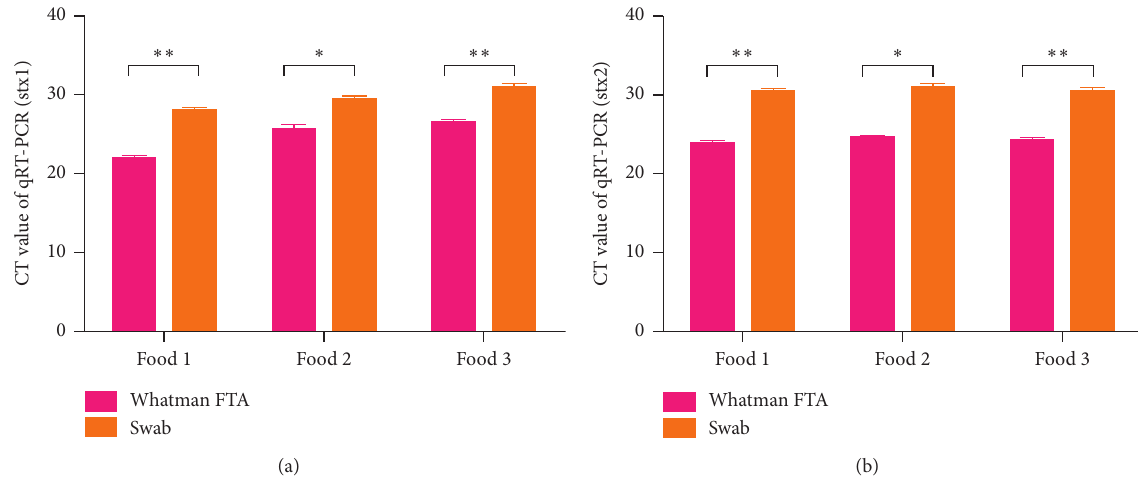
Figure 3: Detection of Escherichia coli O157:H7 genes in food samples containing Escherichia coli O157:H7 contamination by RT-qPCR collected using Whatman FTA cards and swabs. (a) Expression level of the stx1 gene in a serially diluted environmental strain of Escherichia coli O157:H7 samples on Whatman FTA cards and swabs detected by RT-qPCR ( n � 6, ∗ P < 0 . 05 and ∗∗ P < 0 . 01). (b) Expression level of the stx2 gene in an environmental strain of Escherichia coli O157:H7 samples on Whatman FTA cards and swabs detected by RT-qPCR ( n � 6, ∗∗ P < 0 . 01). RT-qPCR: reverse transcription-quantitative PCR; FTA: Flinders Technology Associates. 34